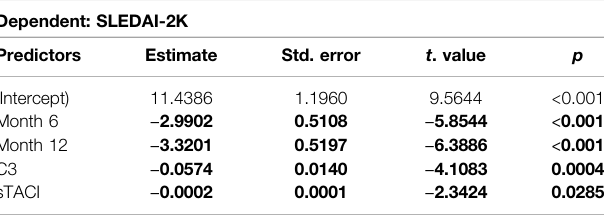
TABLE 4 | Results of robust mixed linear regression model for predictors of SLEDAI-2K. Individual Patient ID was included as random effect in the model. Predictor values were measured at all timepoints.